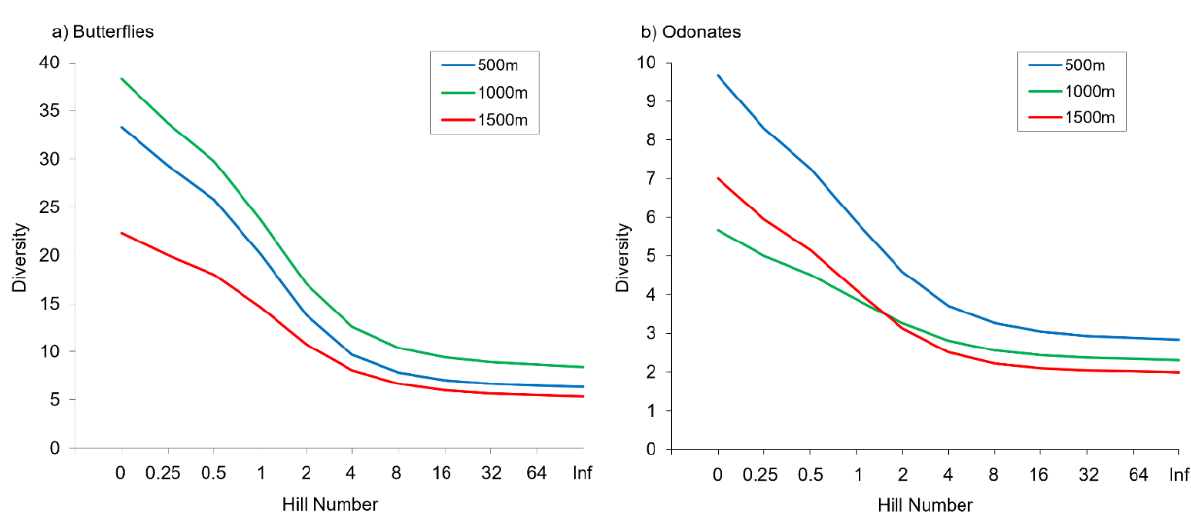
Figure 2. Alpha diversity of butterflies ( a ) and odonates ( b ) at the different elevations represented by Hill numbers.